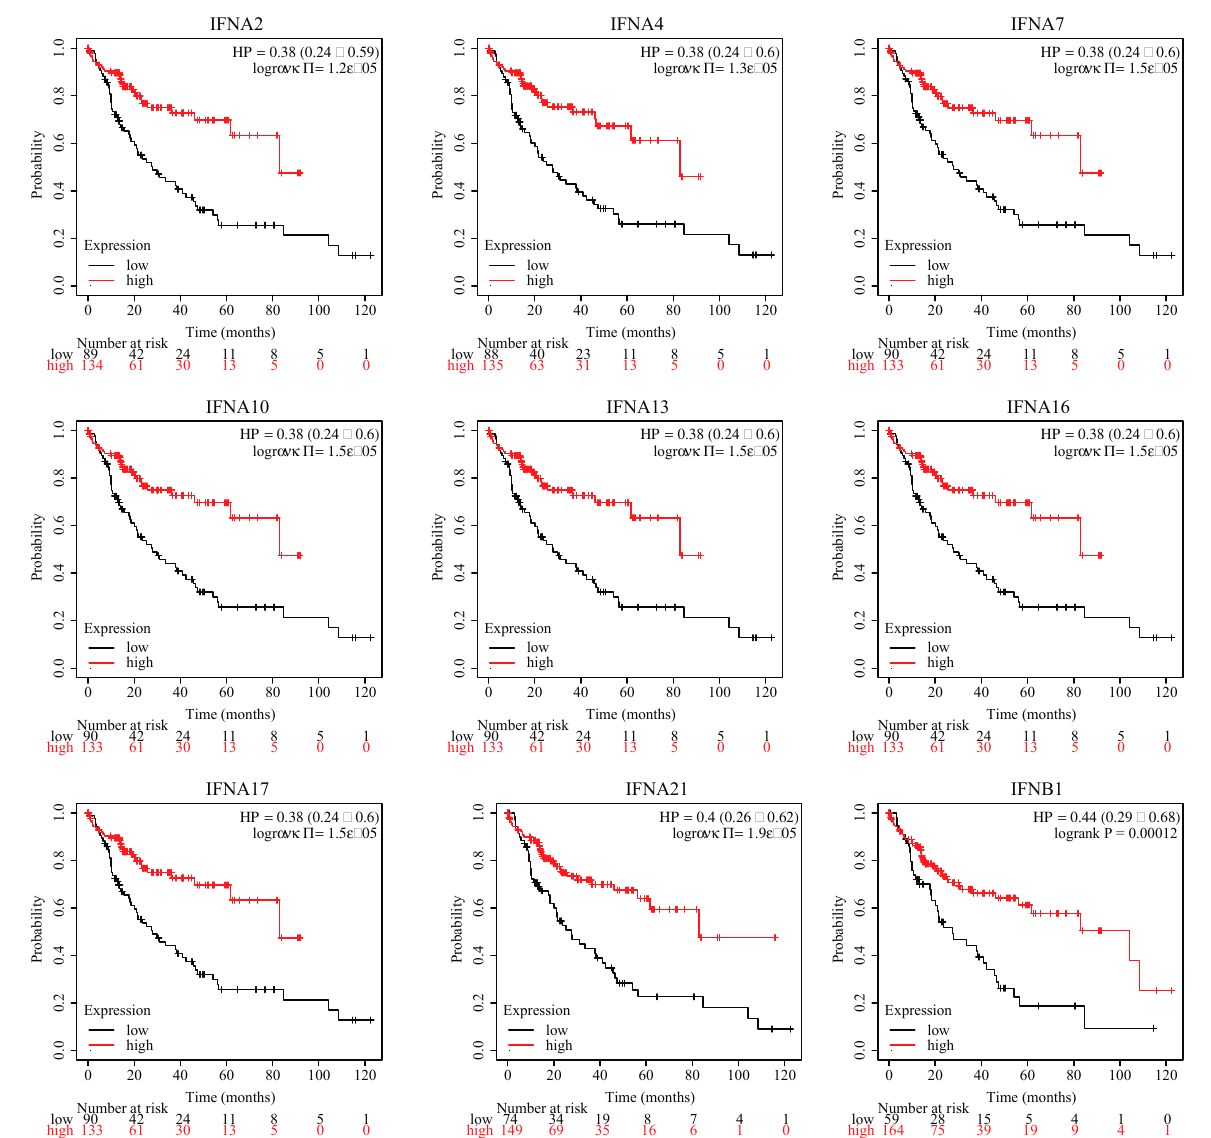
Figure 4. The Kaplan-Meier curves for nine IFN genes. The abscissa represented the survival time of patients with HCC, and the ordinate represented survival rate of patients with HCC. HR of 1 indicates no effect on risk; HR between 0 and 1, good prognosis; HR greater than 1, poor prognosis.